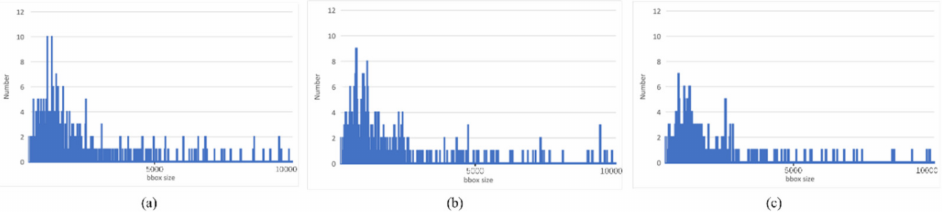
Figure 8. Distribution of ground truth and prediction: ( a ) Distribution of box size in ground truth; ( b ) Distribution of box size in prediction of single-target cascading model; ( c ) Distribution of box size in prediction of multi-target